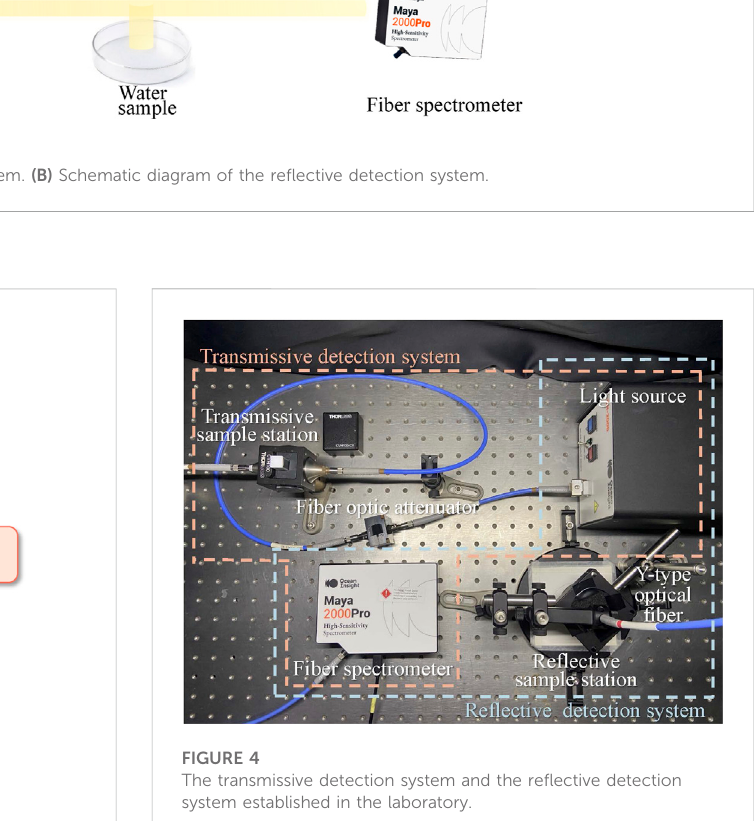
FIGURE 3 COD detection procedure of two systems. The fl owchart on the left is named as Line T, and the fl owchart on the right is named as Line R. T refers to the transmissive detection system, and R refers to the re fl ective detection system.